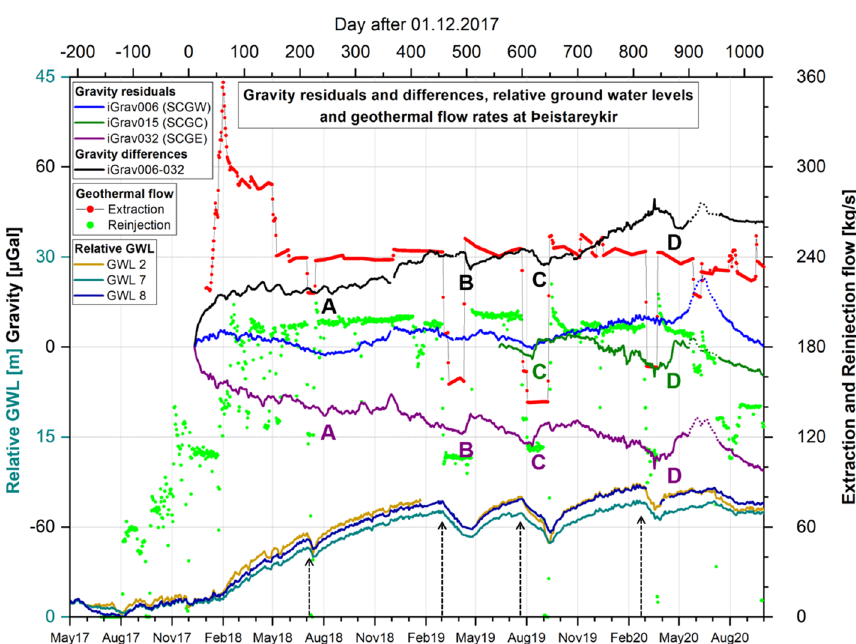
Fig. 7 Comparison of iGrav residuals and gravity differences between iGrav006 and iGrav032 with relative groundwater levels (GWL 2, 7 and 8) and with geothermal extraction and injection flow rates of the Þeistareykir power plant from July 2017 until October 2020; dashed arrows mark the beginning of periods with reduced geothermal flow rates and capital letters mark possible response in the gravity residuals and differences (A, B, C and D; with same colour as the corresponding gravity